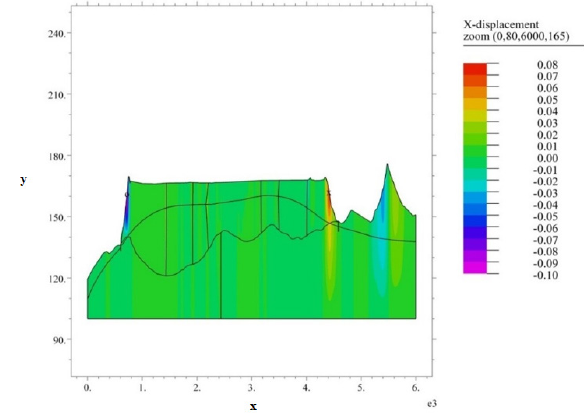
Figure 5: Results for the 2D model – displacement in the x direction.